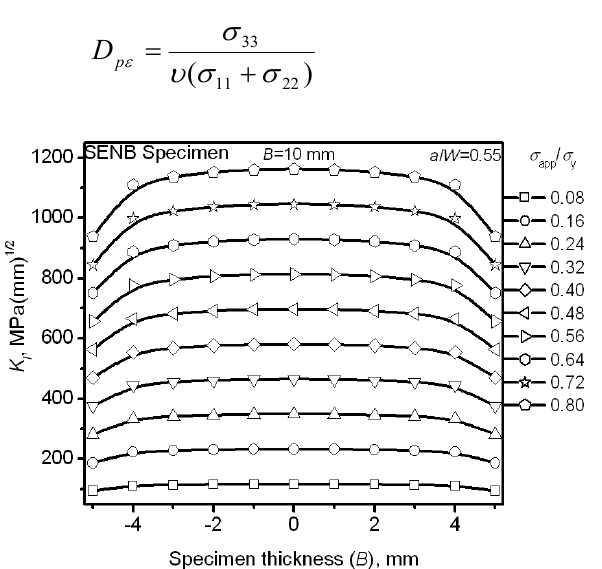
along the crack-front for various I